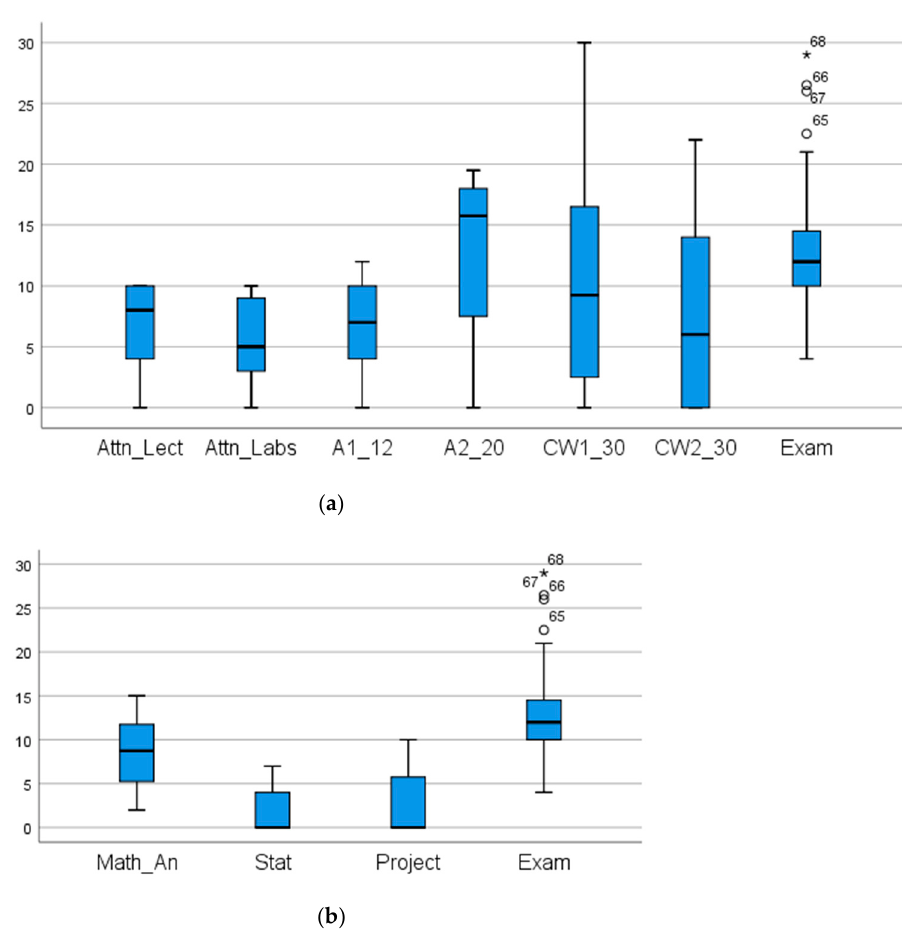
Figure 2. Box plots of the initial predictors and target variable Exam , used in the statistical analyses (nonstandardized): ( a ) preliminary activities and Exam , ( b ) Exam